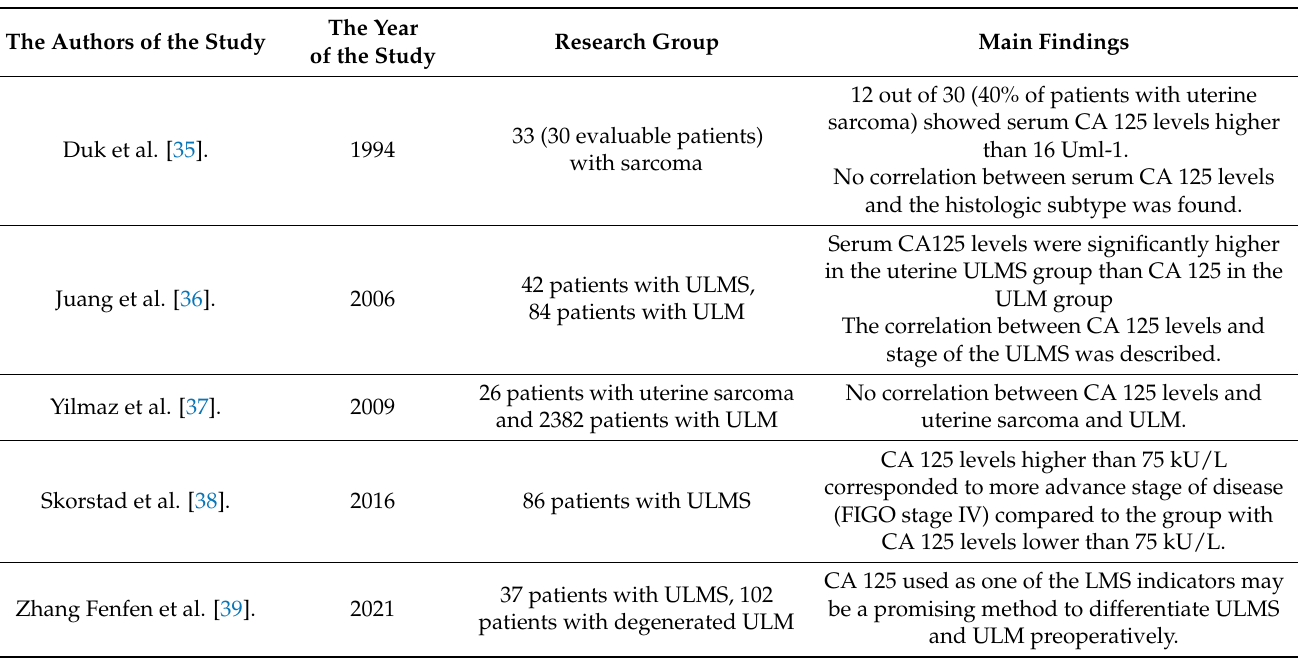
Table 1. The studies of CA 125 levels in ULMS and ULM